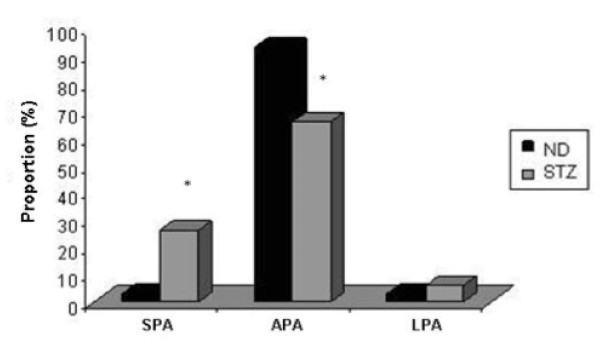
Fetal weight classification of offspring born to mild diabetic (STZ) and non-diabetic (ND) rats. Fetal weight classification is defined as small for pregnancy age (SPA), appropriate for pregnancy age (APA) or large for pregnancy age (LPA). *p < 0.05 -Chi Square Test.